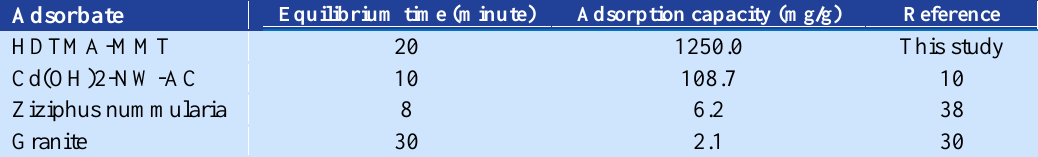
Table 3. The comparison of the adsorption capacities of various adsorbents for BCG Adsorbate Equilibrium time (minute) Adsorption capacity (mg/g)